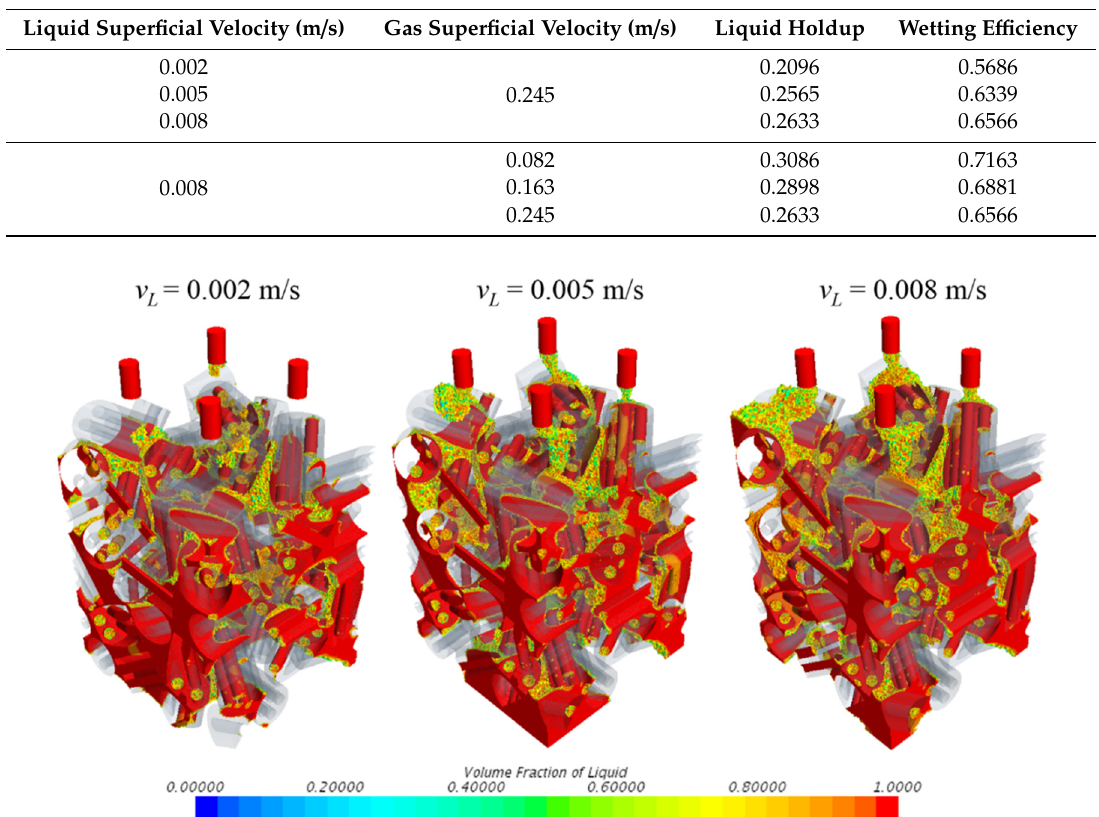
Figure 9. Liquid distributions with different liquid superficial velocities ( v G = 0.245 m/s).